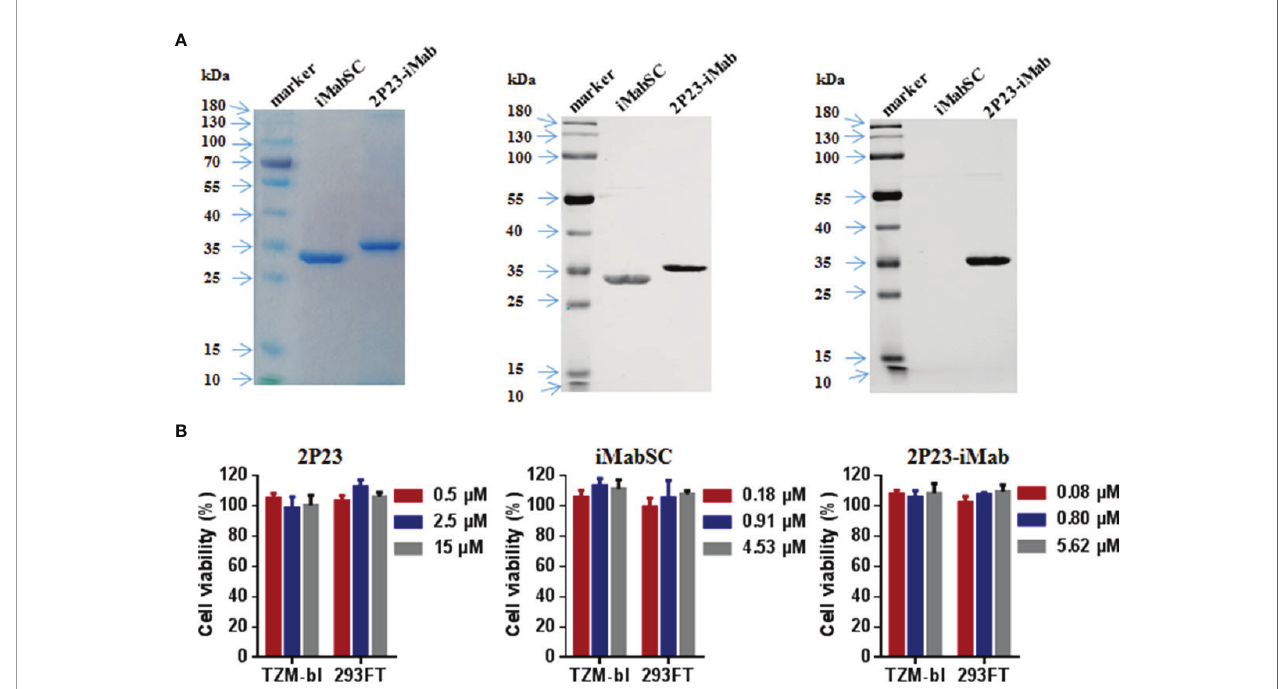
FIGURE 2 | Puri fi cation and characterization of iMabSC and 2P23-iMab. (A) The purity and size of recombinant iMabSC and 2P23-iMab were analyzed by SDS- PAGE gel (left), and the speci fi city of the proteins was veri fi ed by Western blotting with a mouse anti-His antibody (middle) or anti-2P23 peptide antibody (right). (B) Cytotoxicity of 2P23 (left), iMabSC (middle), and 2P23-iMab (right) on TZM-bl and 293FT cell lines were determined by cell counting kit-8 (CCK-8). The experiments were performed in triplicate and repeated three times. Data are expressed as means ± standard deviations